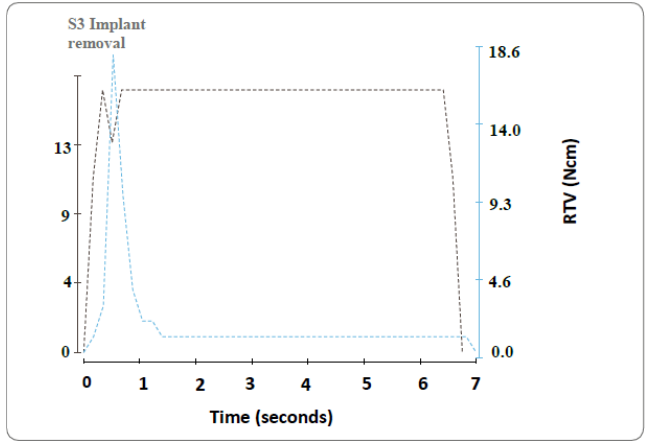
Figure 5. Example of reverse torque value (RTV) evolution during the untightening procedure.